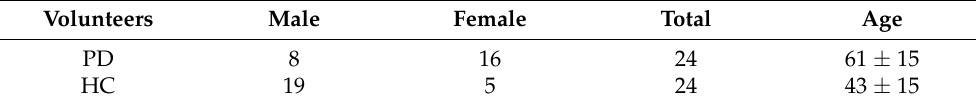
Table 1. The basic characteristics of the research (PD) and control group